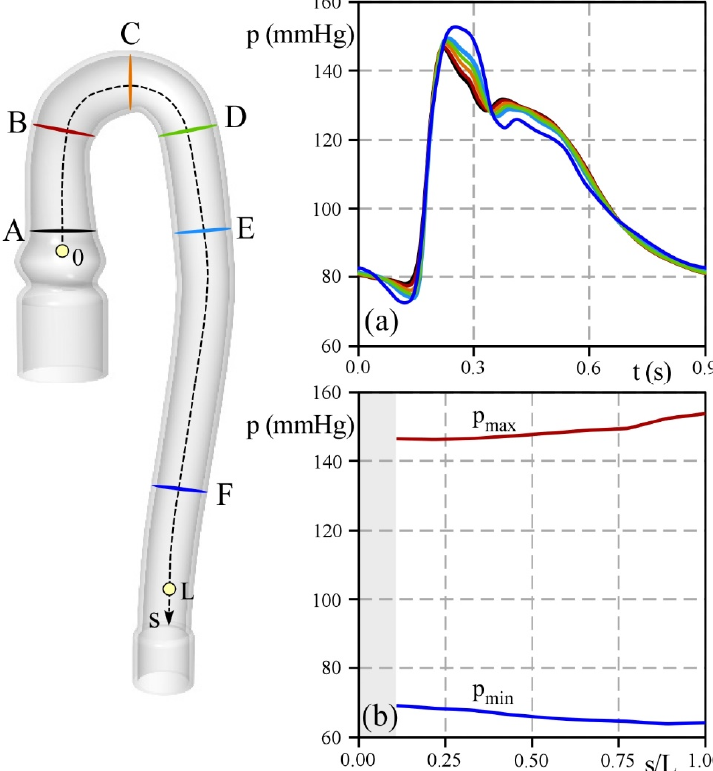
Figure 9. Pressure analysis of the Aorta. ( a ) Time-varying pressure in some sections of the domain, and ( b ) the maximum (red line) and minimum pressures (blue line) calculated along the path line, s/L.